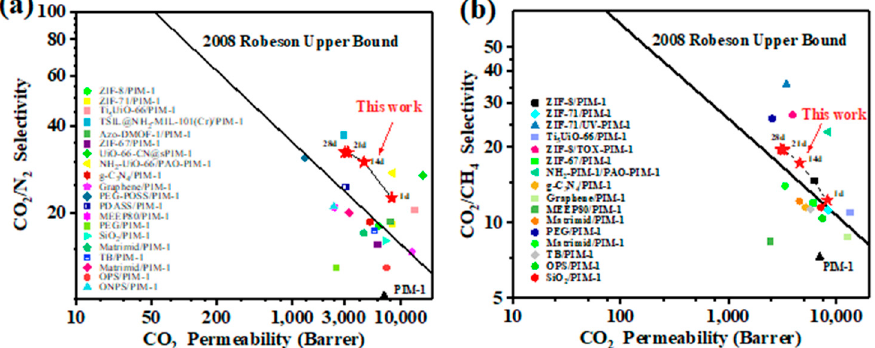
Figure 8. ( a ) Comparison of CO 2 /N 2 performance between UiO-66-NH 2 @IL/PIM-1 MMM and other related MMMs; ( b ) Comparation of CO 2 /CH 4 performance between UiO-66-NH 2 @IL/PIM-1 MMM and other related MMMs.